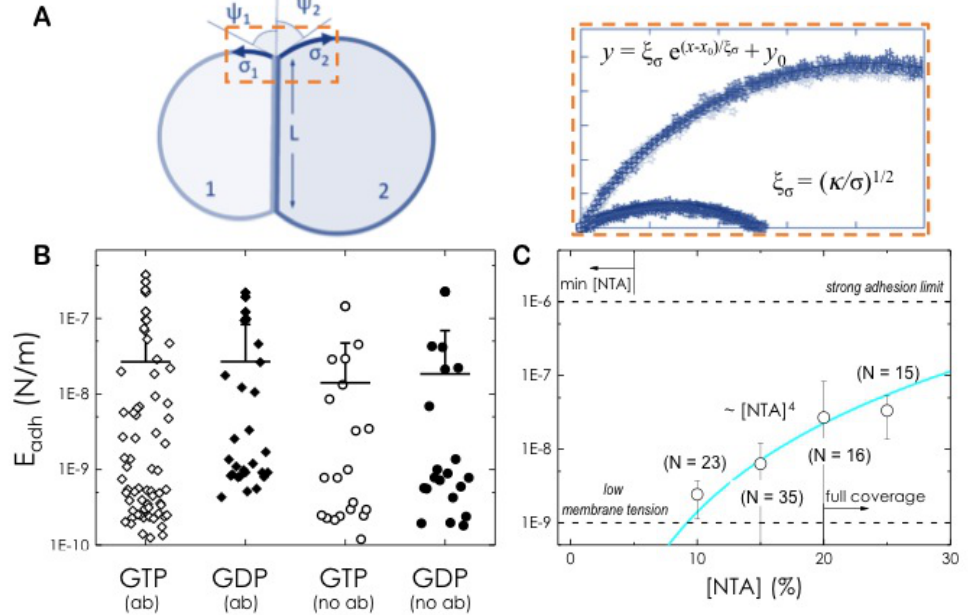
Figure 5. Quantification of adhesion strength . ( A ) Schematic diagram of two GUVs in adhesive contact. Contact angles are denoted by ψ 1 , ψ 2 and σ 1 and σ 2 are the lateral tensions. The vesicle contour was obtained from the pixels with maximum fluorescence intensity (stars in the zoomed area) and ( x − x 0 ) / ξ σ + y fitted to the function y = ξ 0 from the rim of the contact area up to the asymptote in the free σ membrane. Lateral tension values were directly calculated using the correlation length ξ σ = ( κ / σ ) 1/2 , where κ = 10 κ B T is the reported bending rigidity of POPC-containing GUVs [34]. ( B ) Adhesion strength of POPC/DOGS-NTA GUVs (80:20 mol%) carrying hs Mfn1 proteins under GTP (N = 35, 10) or GDP (N = 16, 10) incubation and the presence (squares) or absence (circles) of α -Mfn1-488 respectively. ( C ) Adhesion strength of POPC/DOGS-NTA GUVs binding hs Mfn1 proteins under GDP incubation and as a function of the concentration of NTA. In parenthesis, the number of adhesive events analysed. Data were fitted to Equation